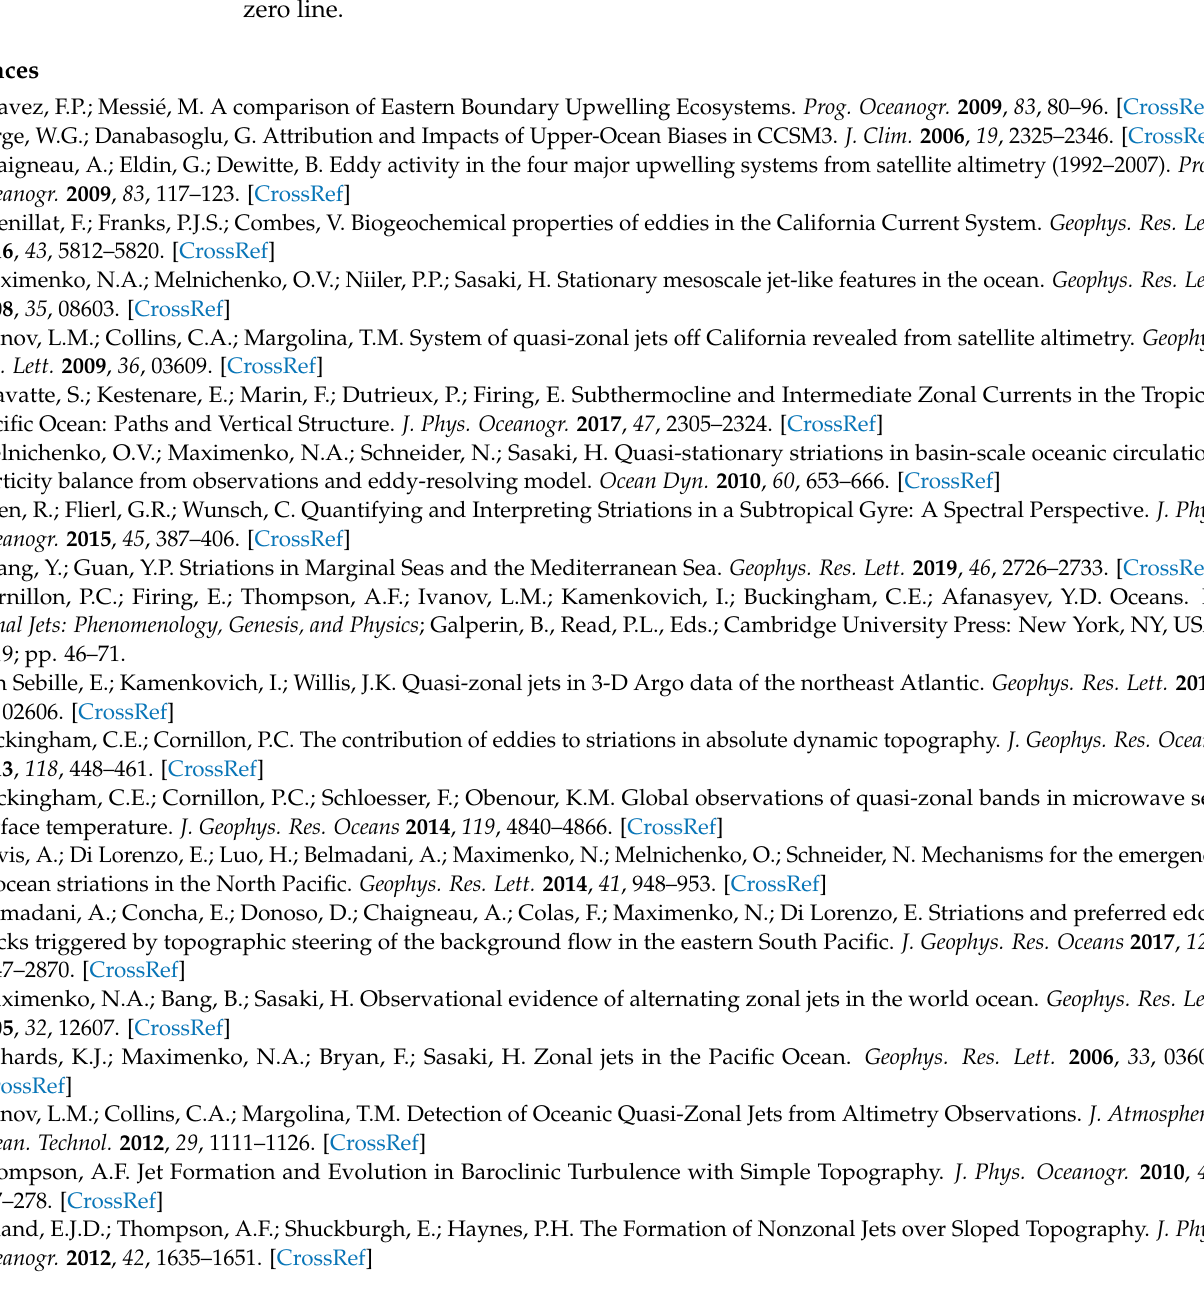
Table A2. Computed values for the number m of independent observations associated with the cross-striation profiles on Figures 6 and 11. The values for the number n of independent observations over the SST, Chl-a (2012–2018), and SSS (2015–2018) records are also indicated. Region ENP ENP CTZ ESP SST n = 33, m = 396 n = 33, m = 198 n = 26, m = 312 SSS n = 19, m = 228 n = 19, m = 114 n = 15, m = 180 Chl-a n = 33, m = 198 n = 26, m = 312 Figures S3–S8 (respectively Figures S9 and S10) are obtained after the application of Equation (A9) and multiplication factor 1.64 to derive 90% confidence intervals for the various mean profiles shown on Figure 6 (respectively Figure 11). The profiles are then considered statistically significant at the 5% level wherever these intervals do not cross the zero